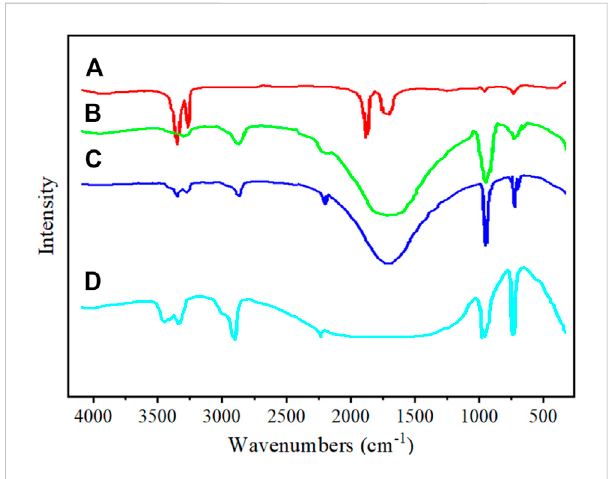
FIGURE 5 Infrared spectrogram, (A) Unmodi fi ed GCC, (B) TCA-201